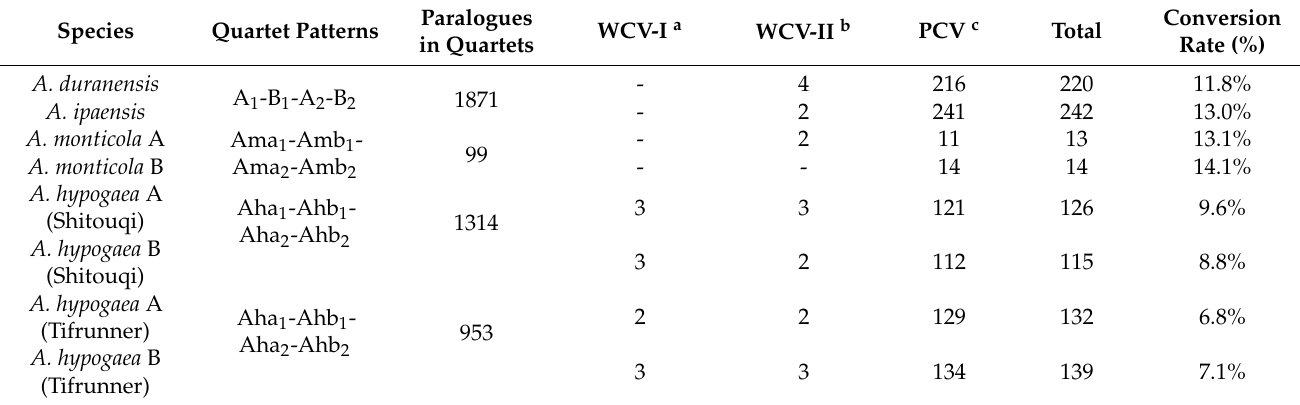
Table 1. Converted paralogues in peanut